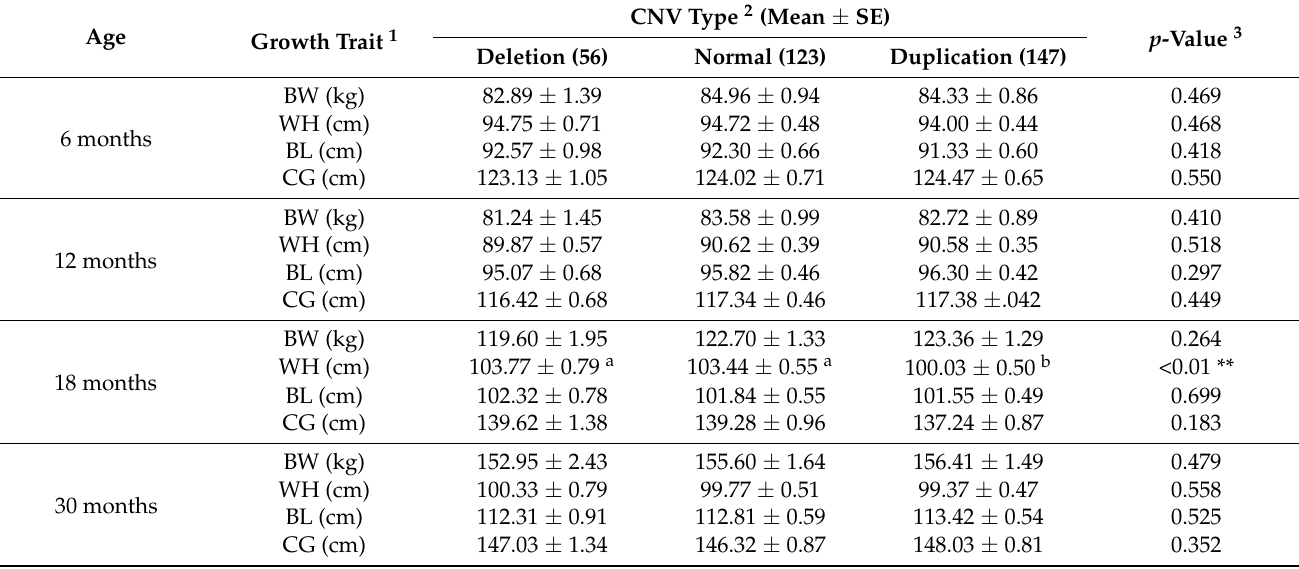
Table 2. Association analysis between SOX5-CNV and growth traits.